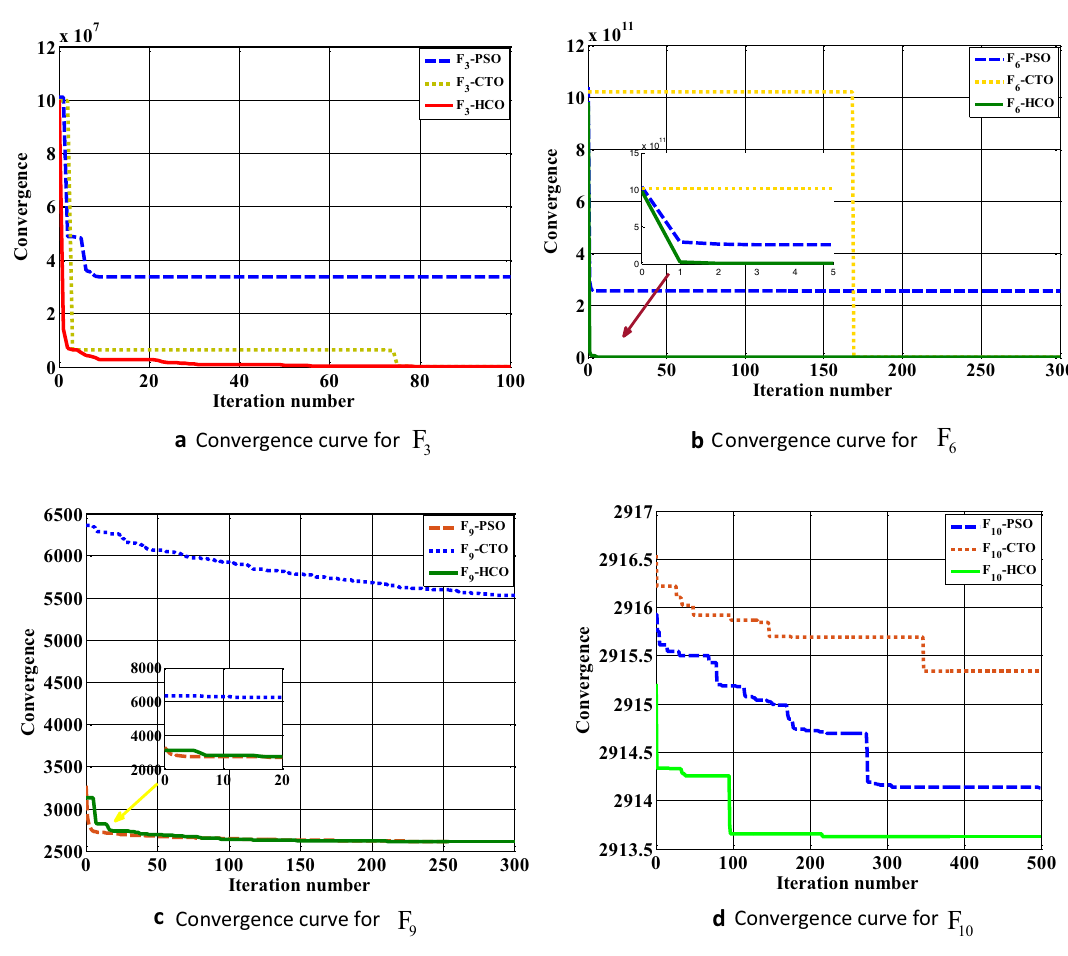
F Convergence curve for Convergence curve for 10